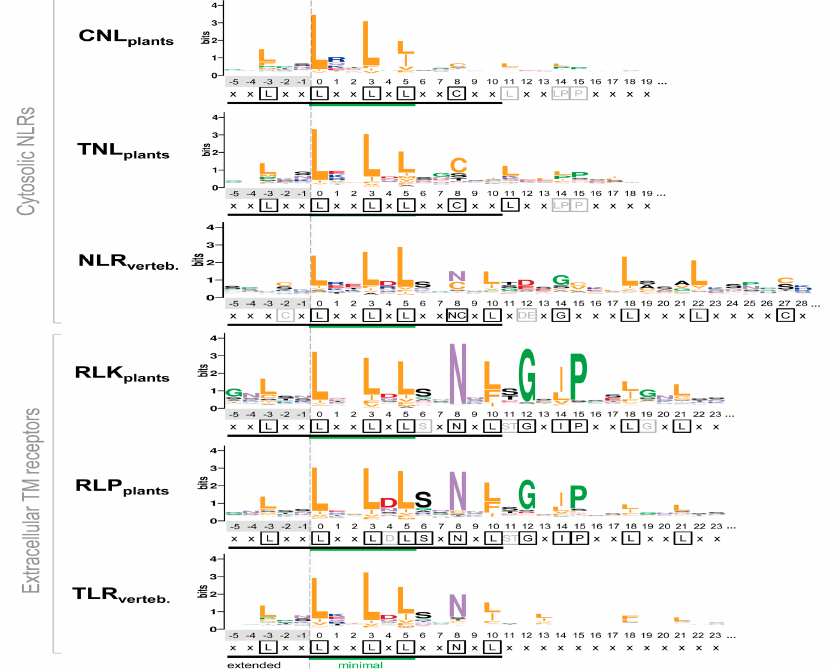
Figure 5. Consensuses of the LRR motifs predicted by LRRpredictor across different classes. Logo heights correspond to amino acid relative entropy (in bits), higher heights implying higher conservation. A consensus for each class is displayed bellow each logo, highly conserved positions being shown in black boxes, while less conserved in gray. Minimal motif ‘L 0 xxL 3 xL 5 ’ (green line) and the extended motif (black line) are indicated below each logo. Amino acids are colored according to their properties as in Figure 1d.